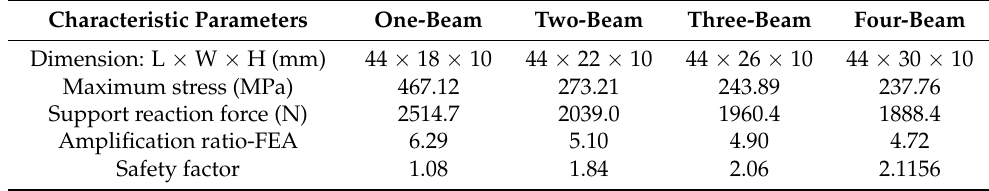
Figure 4. Stress analysis of single-stage rhombus frame with different number of beams. ( a ) One- beam; ( b ) Two-beam; ( c ) Three-beam; ( d ) Four-beam. Table 4. Partial characteristics and analytical results of single-stage rhombus frames with different number of